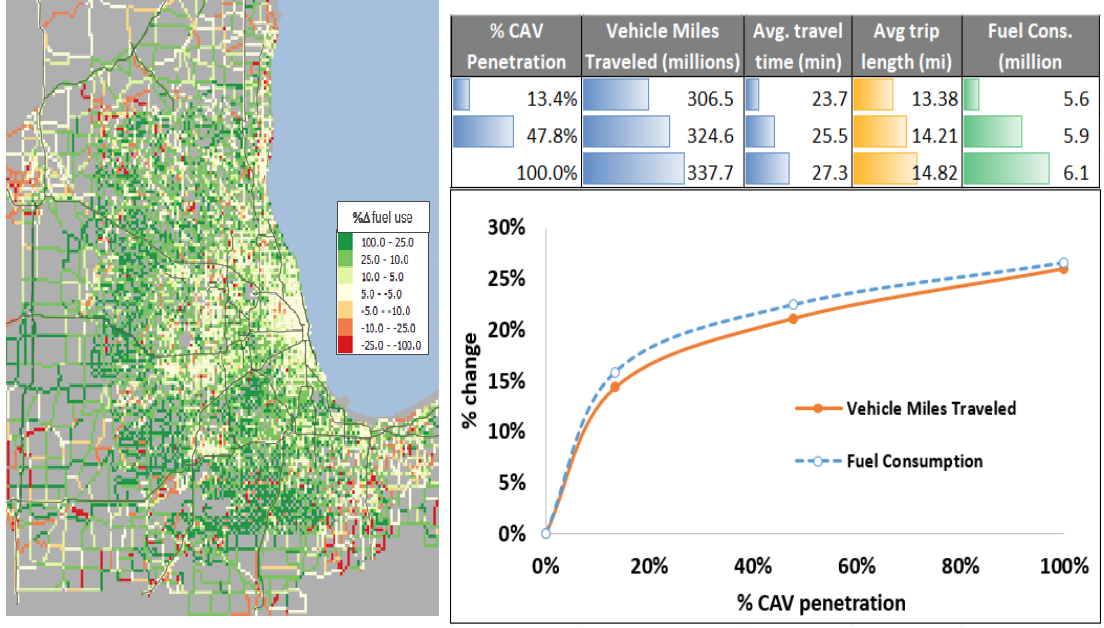
Figure 3. Summary of CAV study simulation